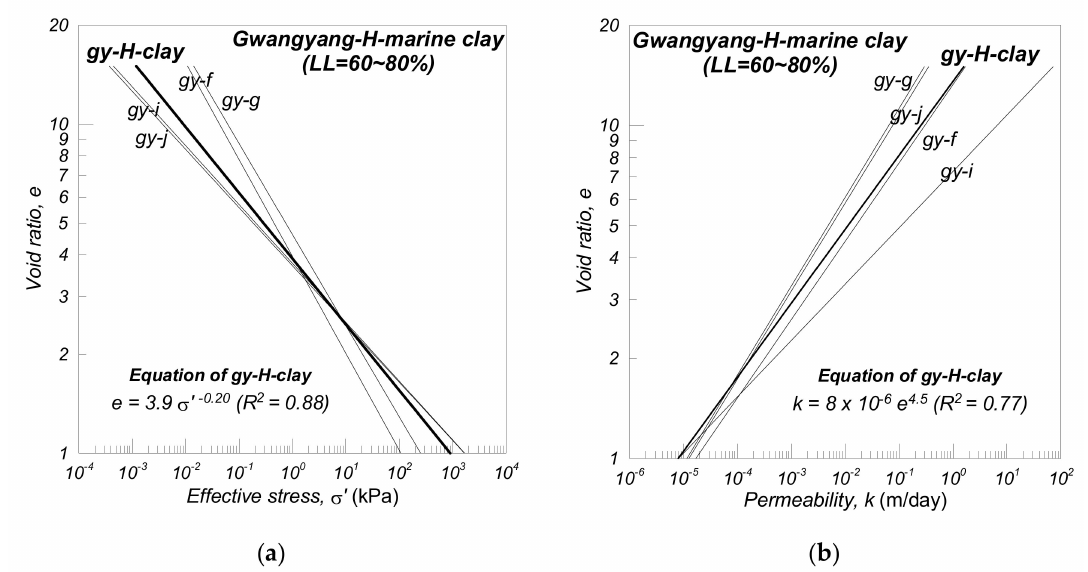
Figure 13. Constitutive relationship of Gwangyang H marine clay (gy-H-clay): ( a ) void ratio vs. e ff ective stress; ( b ) void ratio vs.